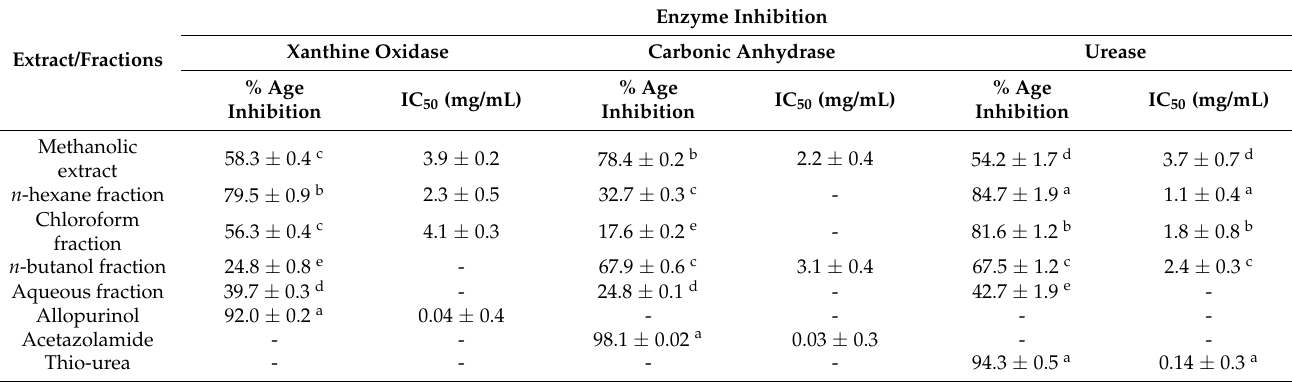
Table 5. Enzyme inhibition assays of Neurada procumbens